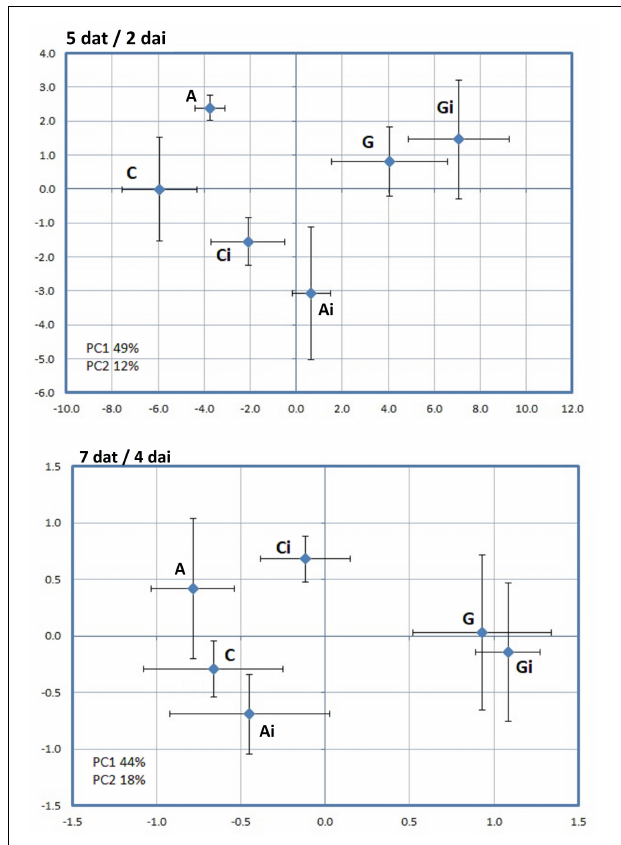
FIGURE 8 | Principal component analysis (PCA) performed for the spots whose volume significantly changed in abundance ( p -value < 0.05) between Greenforce CuCa (G), ASM (A), and Control (C) and treated and inoculation (i) with H. vastatrix, (Ci, Gi, Ai), at 5dat/2dai and